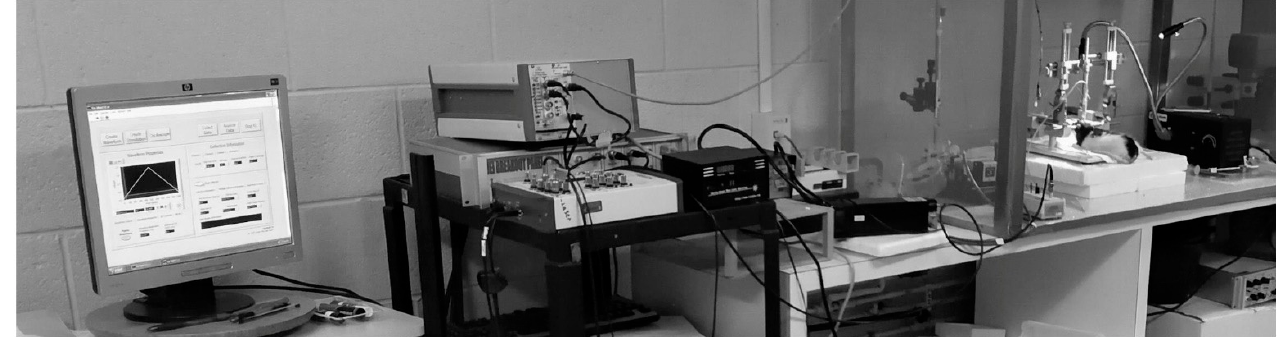
Figure 1. Modern FSCV set up for the in vivo monitoring of extracellular dopamine in the rodent brain. The voltammetry data collection hardware and software were developed in Electronics Design Facility at University of North Carolina at Chapel Hill. FSCV system is combined with the equipment for optogenetic experiments via TTL signal.